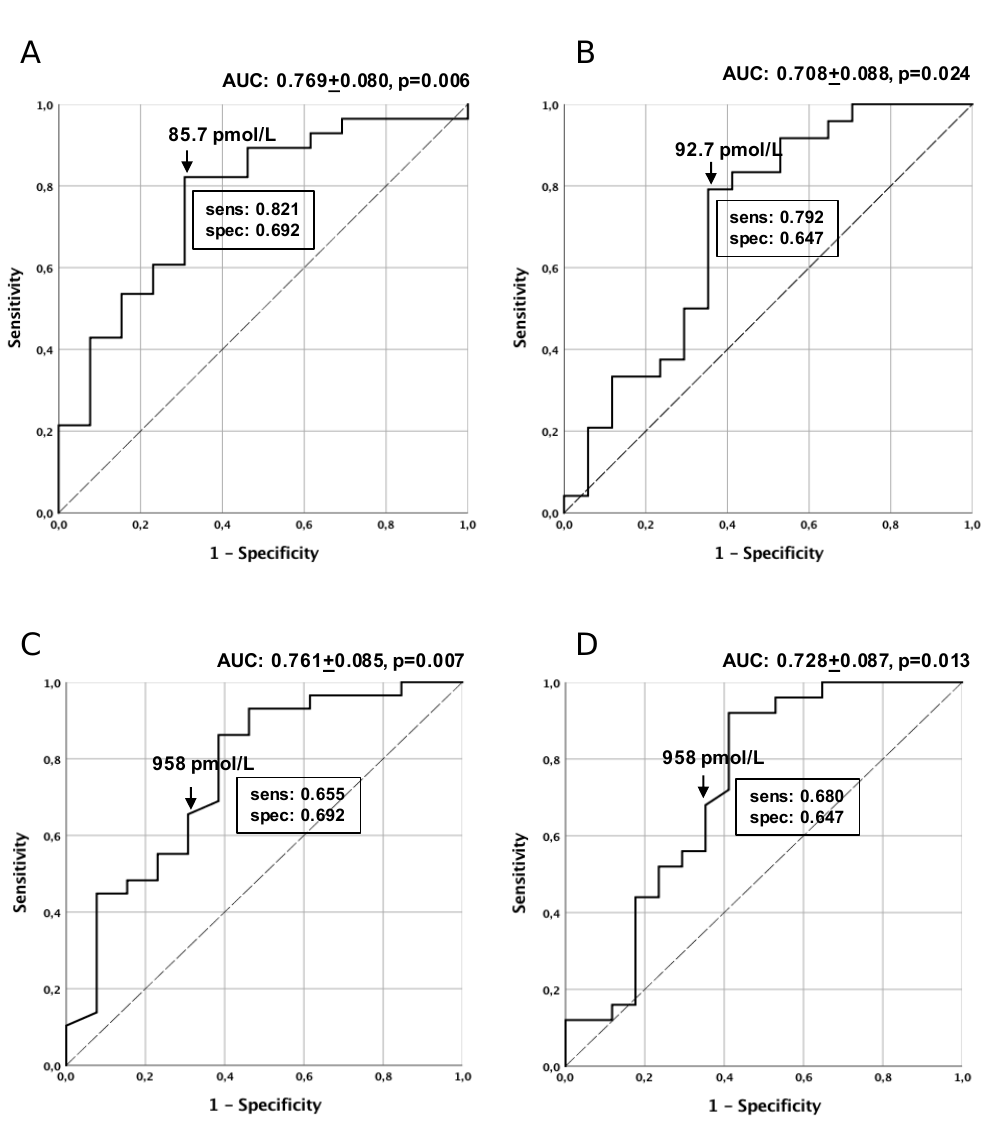
Figure 4. ROC analysis of seminal holoTC and CBL potency in predicting sperm number and concentration. ROC analysis of seminal holoTC predictive power for sperm number ( A ) and sperm concentration ( B ), and for seminal CBL predictive power for sperm number ( C ) and sperm concentration ( D ). Accuracy ± SD (AUC) and p value are indicated for each analysis, along with the cut-off value of holoTC and CBL associated with the best value of sensitivity (sens) and specificity (spec) of the method.